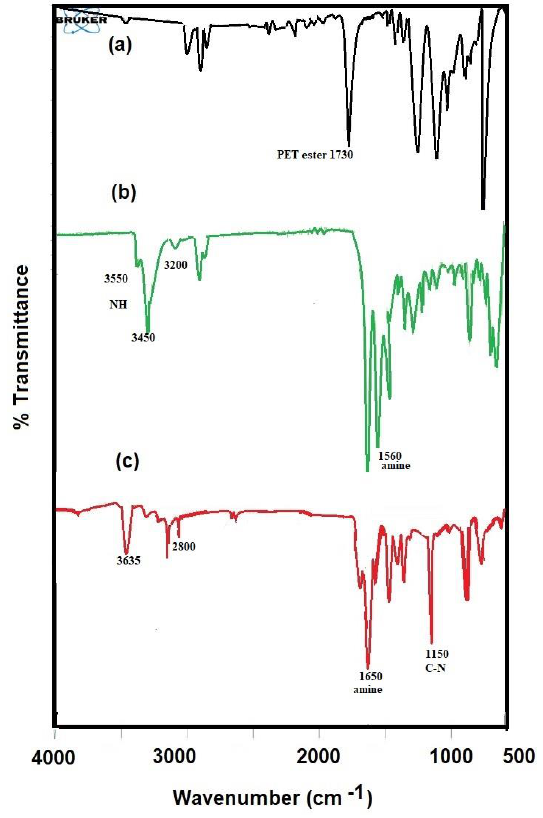
Figure 2. FTIR spectra of ( a ) PET, ( b ) APA and ( c ) PAIIL.